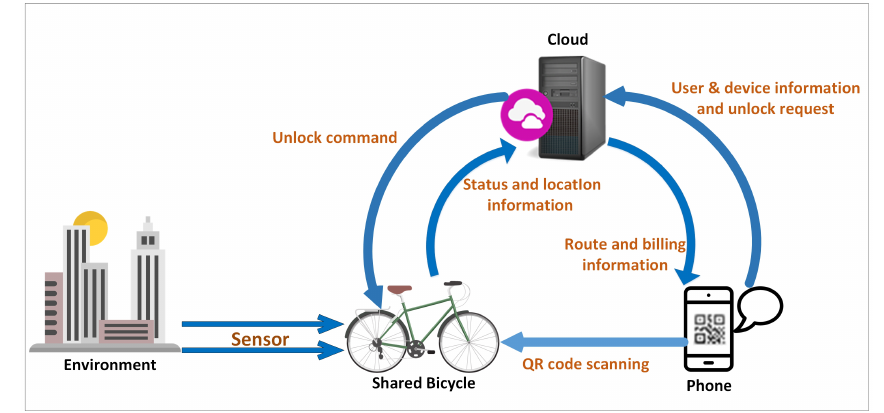
Figure 5. Purpose of IoSB.